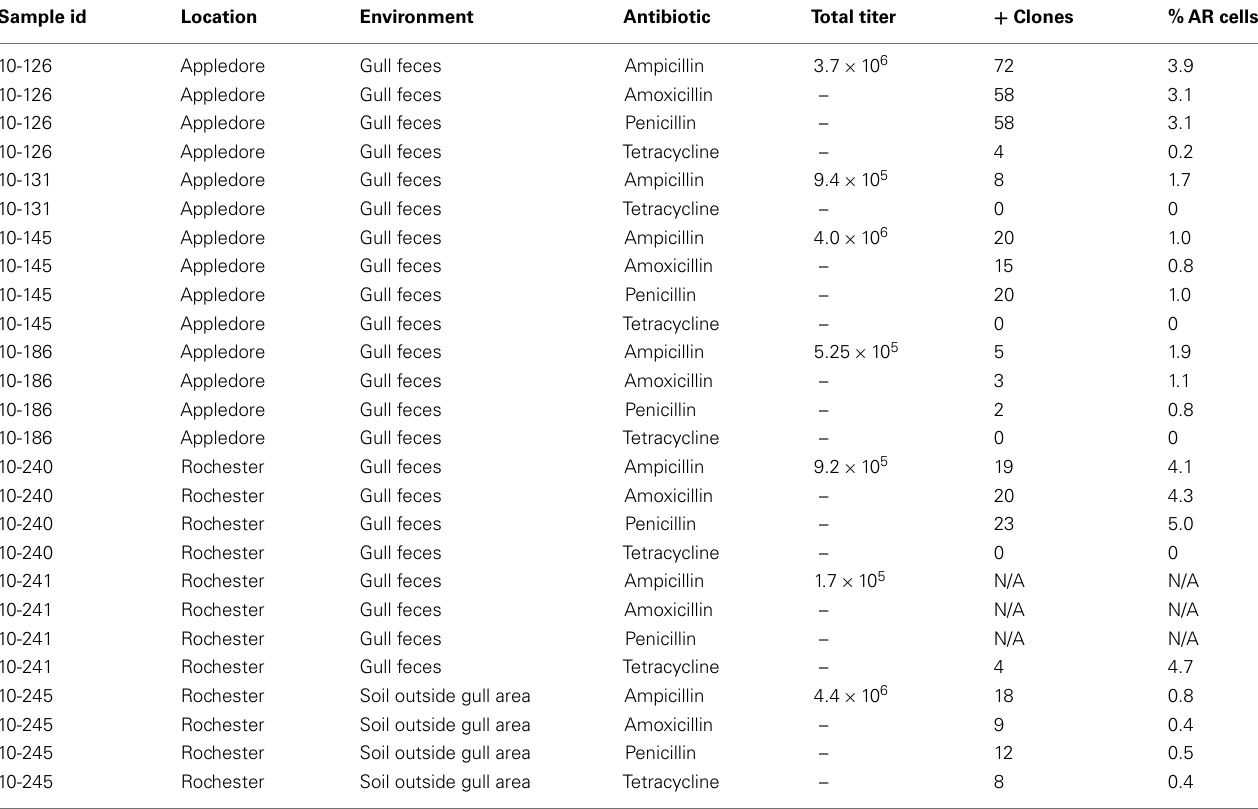
Table 1 | Metagenomic sample overview, including a list of sample IDs and description, titer of each clone library, and the number of positive (resistant) clones to each